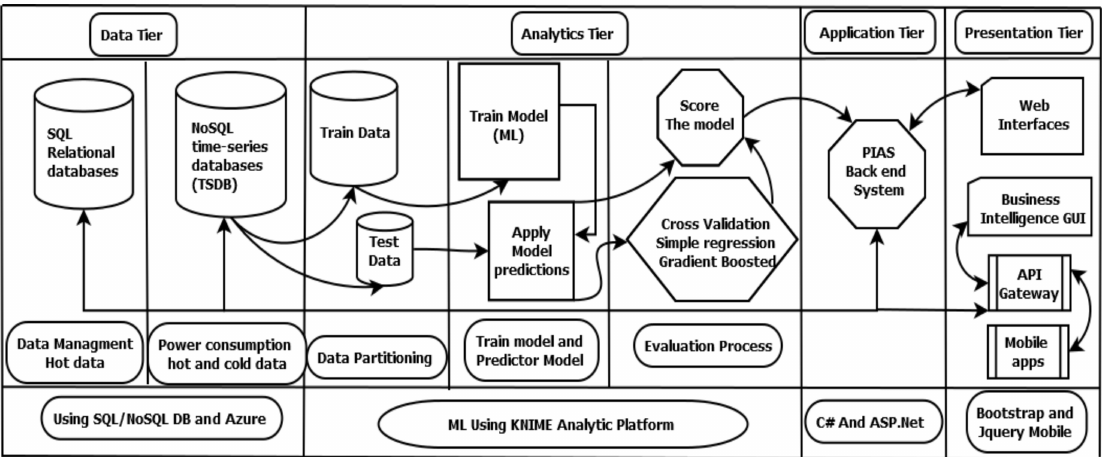
Figure 1. PIAS Tiers